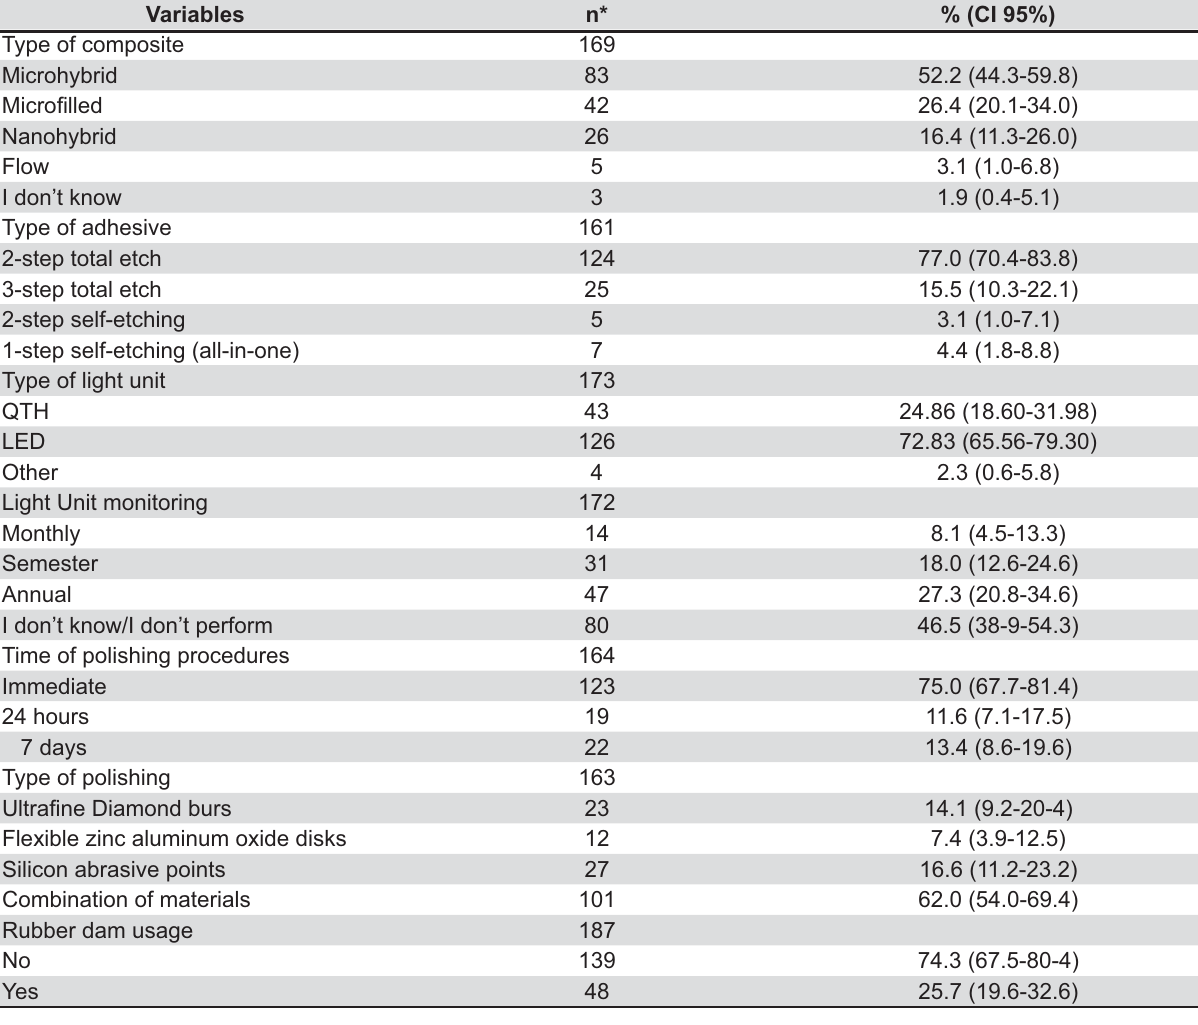
Table 1- Number of observations and frequencies of the studied variables among dentists